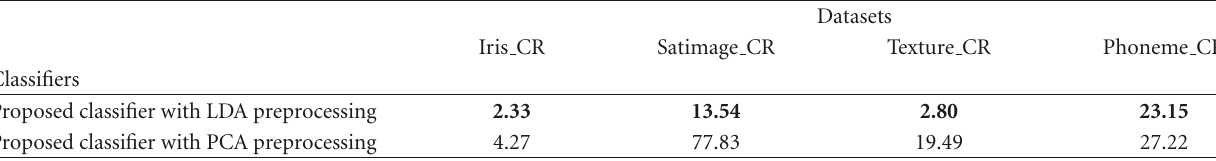
Table 2: Error rates in percentage for the proposed classifier using PCA or LDA preprocessing. The best results are highlighted in boldface.